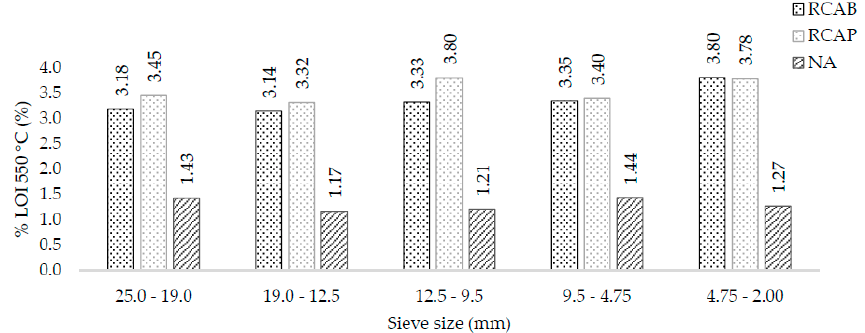
Figure 6. LOI550 °C of NA, RCAP, and RCAB by size. Figure 6. LOI550 ◦ C of NA, RCAP, and RCAB by